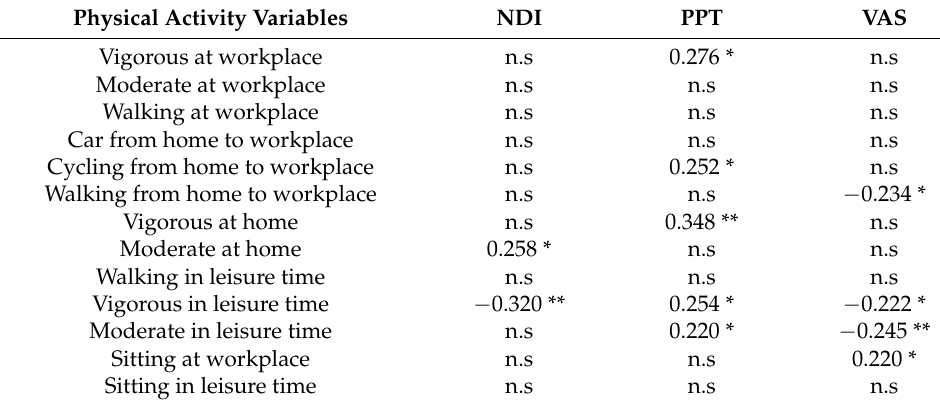
Table 4 describes Pearson’s correlation coefficients between physical activity features and neck pain severity outcomes. NDI showed a positive correlation with moderate physical activity at home ( p < 0.05) and a negative correlation with vigorous physical activity during leisure time ( p < 0.01); VAS was positively correlated with sitting time at work ( p < 0.05) and negatively correlated with both vigorous ( p < 0.05) and moderate ( p < 0.01) physical activity during leisure time and walking time from home to their workplace ( p < 0.05); PPT was positively correlated with vigorous physical activity at home ( p < 0.01), work and leisure time (also moderate) and cycling from home to their workplace (all, p < 0.05). Table 4. Physical activity associations with pain-related outcomes.